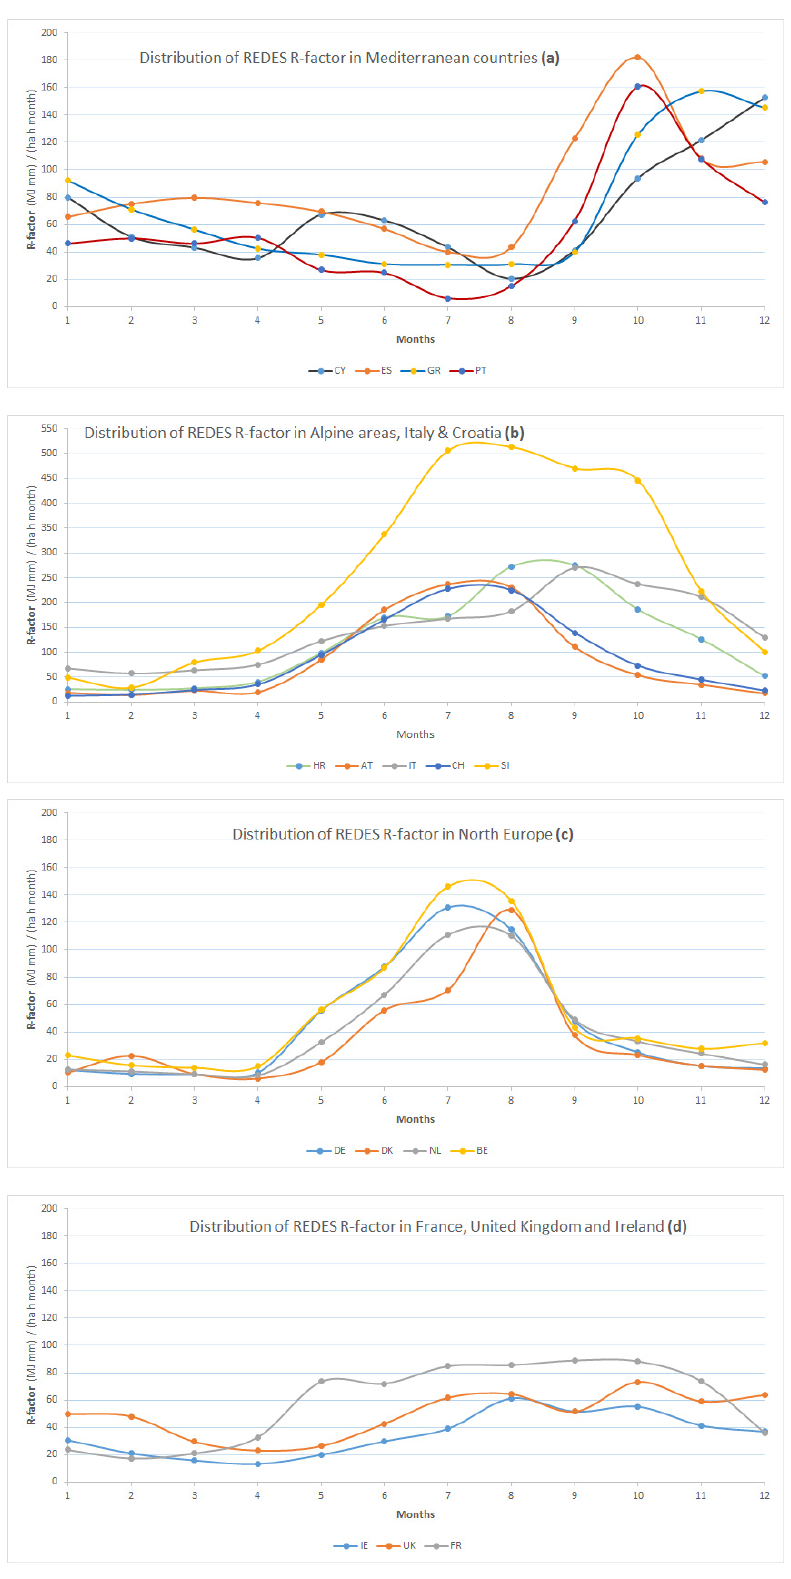
Figure 6. The main regional patterns of monthly rainfall erosivity in Europe: ( a ) Mediterranean countries (CY—Cyprus, GR—Greece, ES—Spain, PT—Portugal); ( b ) Alpine areas, Italy and Croatia